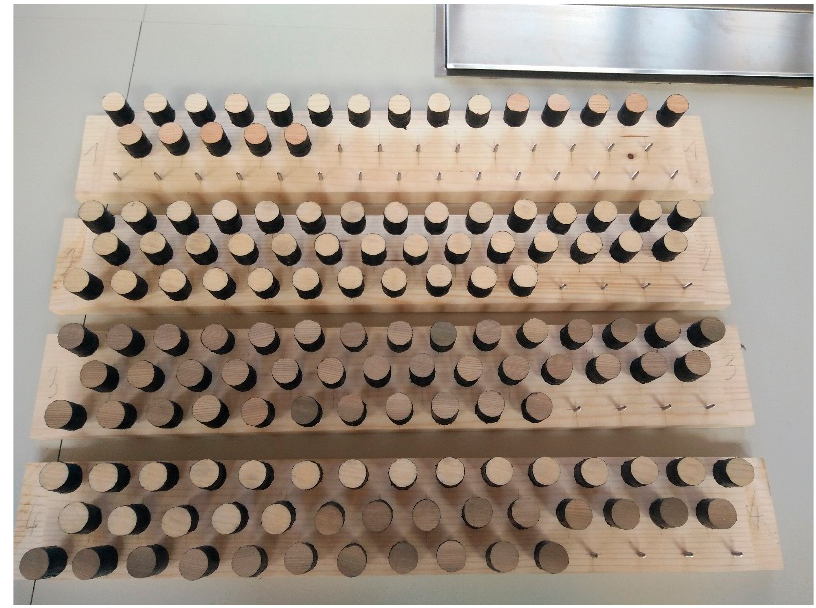
Figure 1. Cylindrical samples prepared for outdoor testing.